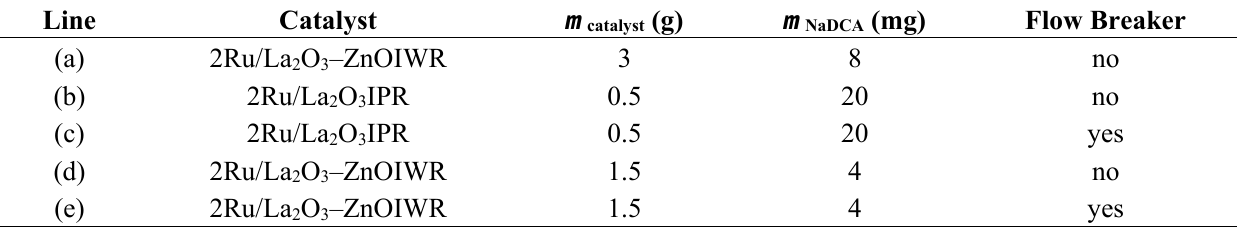
Table 2. Reaction conditions of the different experiments shown in Figure